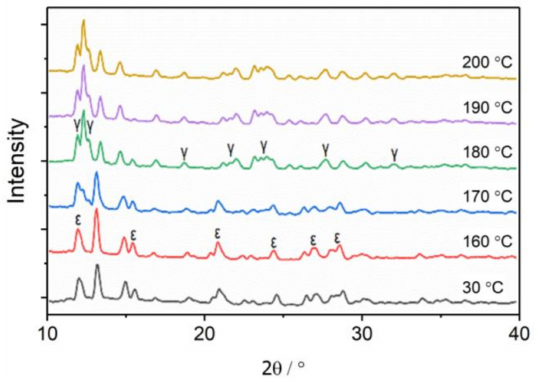
Figure 2. WAXS curves of CL-20 at different